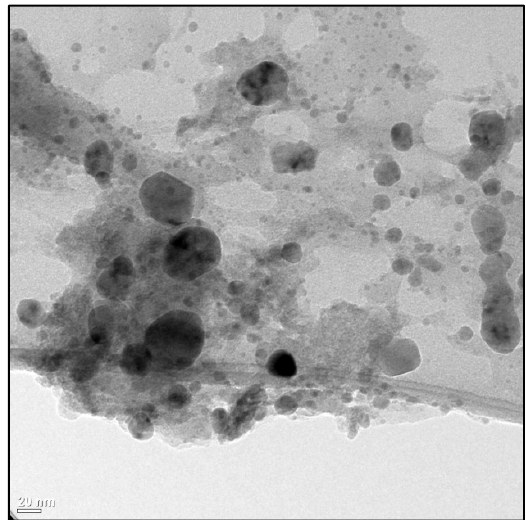
Figure 5. Morphology of copper nanoparticles (Cu NPs) determined by transmission electron microscopy